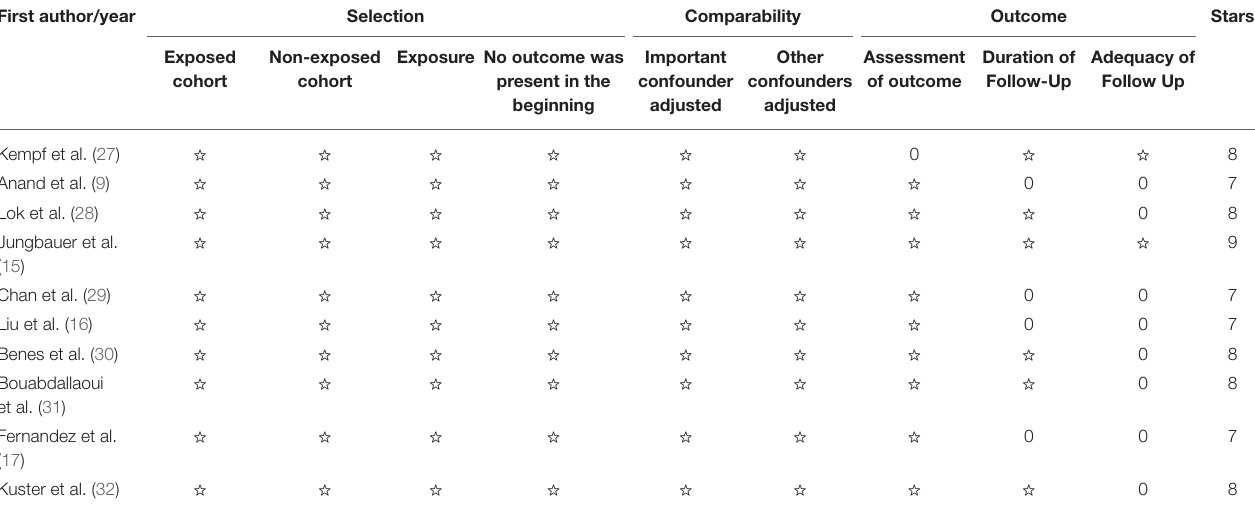
TABLE 2 | Quality assessment of each included